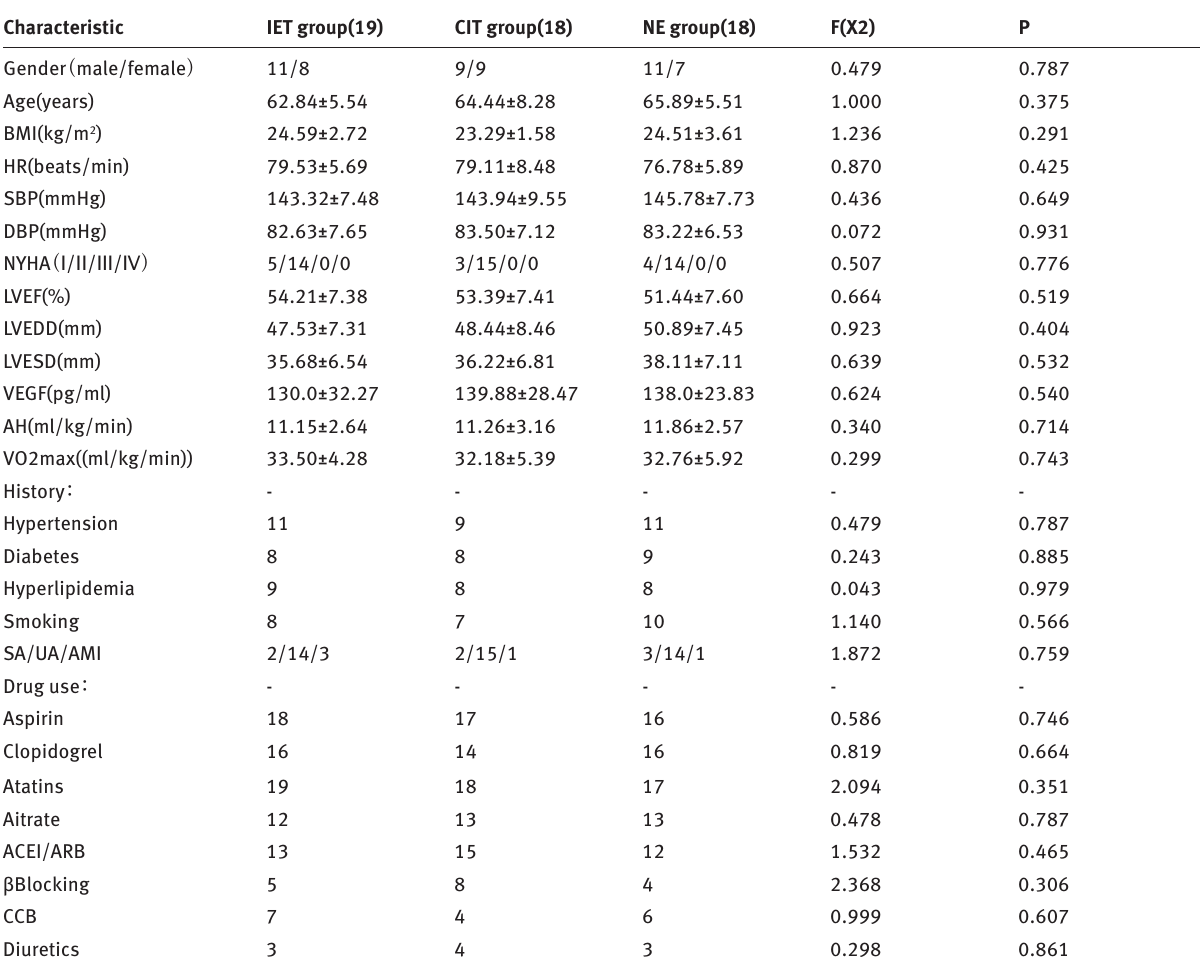
Table 1: Comparisons of baseline data among the three groups